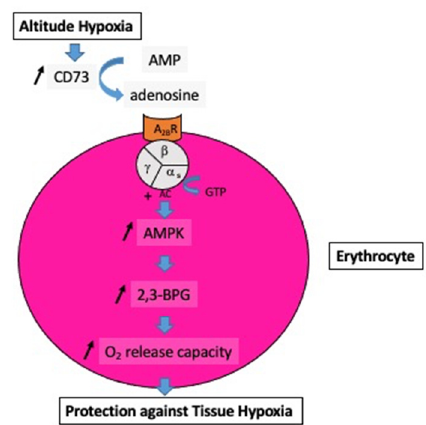
Figure 1. Impact of the increase in extracellular adenosine on the oxygen release capacity from erythrocytes. At high altitudes, hypoxia increases the activity of soluble ecto-5 ′ -nucleotidase (CD73), which converts AMP into adenosine. The subsequent increase in extracellular adenosine induces, via the erythrocyte A 2B receptor (A 2B R) and via the complex guanosine triphosphate (GTP-alpha s subunit of the heterotrimeric G protein), an increase in adenyl cyclase activity (AC) followed by activation of AMP-activated protein kinase (AMPK), and finally the production of 2,3-bisphosphoglycerate (2,3-BPG), which enhances the oxygen (O 2 ) release capacity to peripheral tissues. The increase in adenosine extracellular concentration is a major actor in hypoxia- induced vasodilation through activation of A 2A and A 2B receptors [23,24]. Vasodilation directly acting on the vascular smooth muscle, reducing vascular tone, and increasing